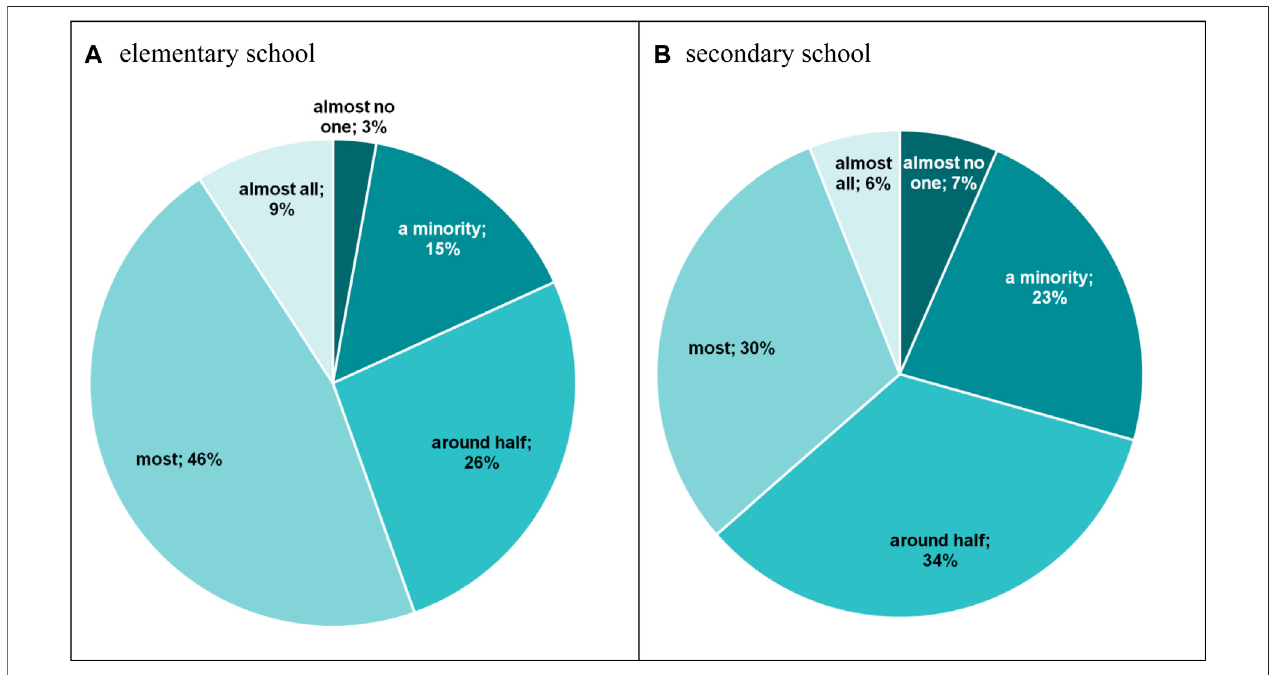
FIGURE 8 | Percentages of teachers giving the indicated responses to the question “ In your opinion, what percentage of students managed to obtain at least the same learning progress during distance teaching that could have been expected during classroom teaching? ” (A) elementary school. (B) secondary